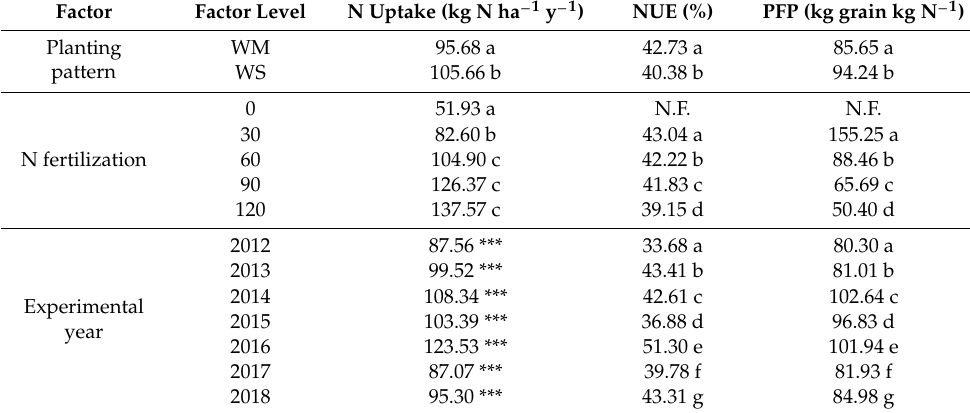
Table 4. Planting pattern, nitrogen fertilization and experimental year influence on N uptake, N use e ffi ciency (NUE) and partial factor productivity (PFP). Statistical di ff erences among N uptake, NUE and PFP within planting pattern, N- fertilization doses and experimental